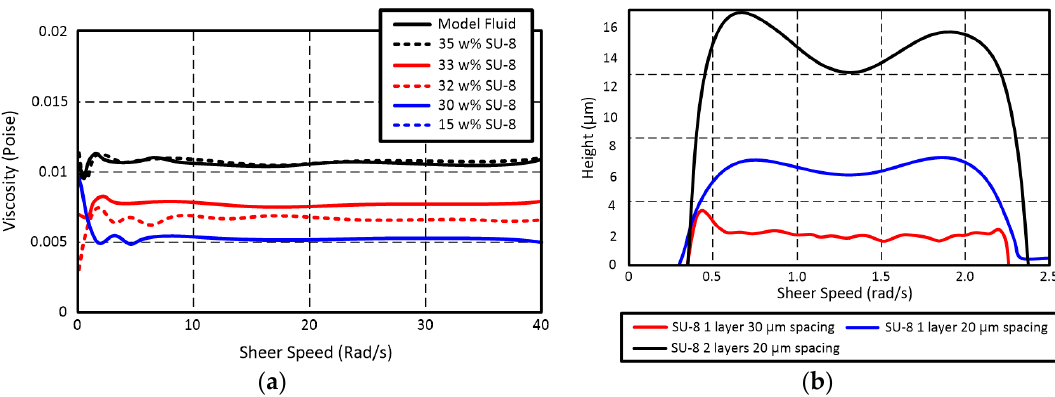
Figure 8. ( a ) Rheometric analysis and ( b ) thickness of inkjet-printed SU-8 ink.